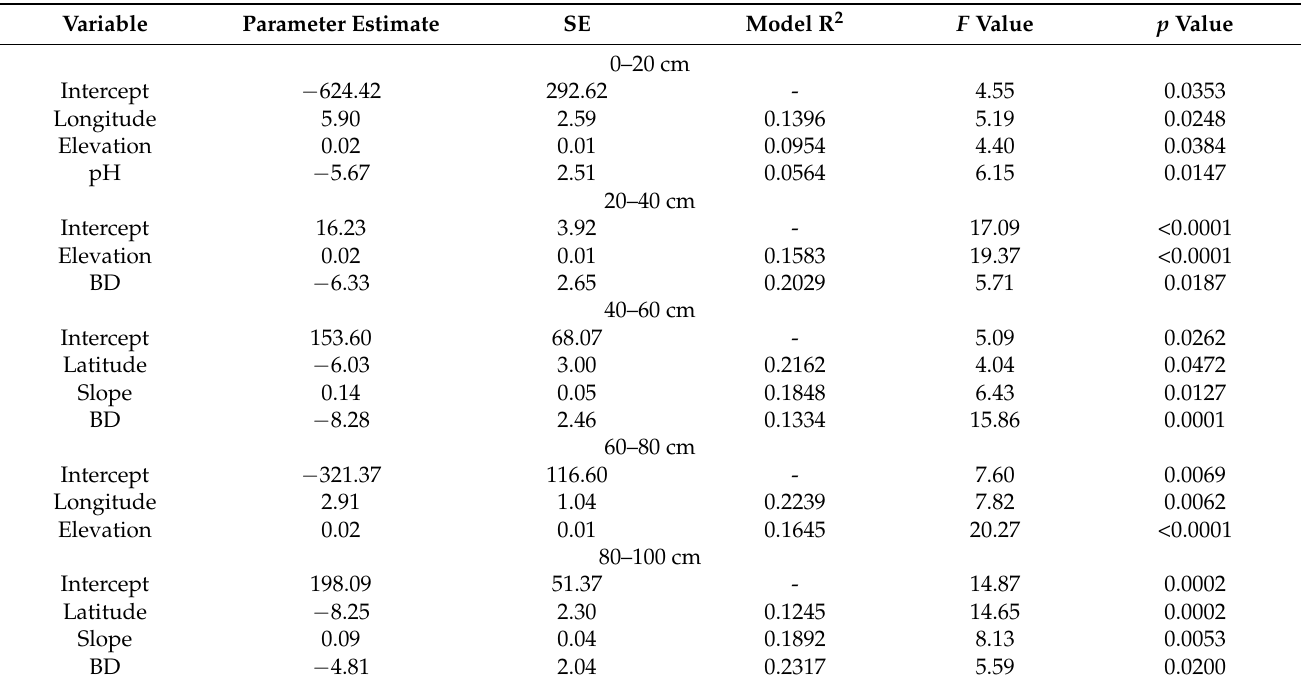
Table 2. Stepwise regression of surface topology and physicochemical property to soil organic carbon stock in Udults soils at different depths for a secondary forest and Eucalypt ( Eucalyptus obliqua L’H é r.), Litchi ( Litchi chinensis Sonn., 1782), Masson